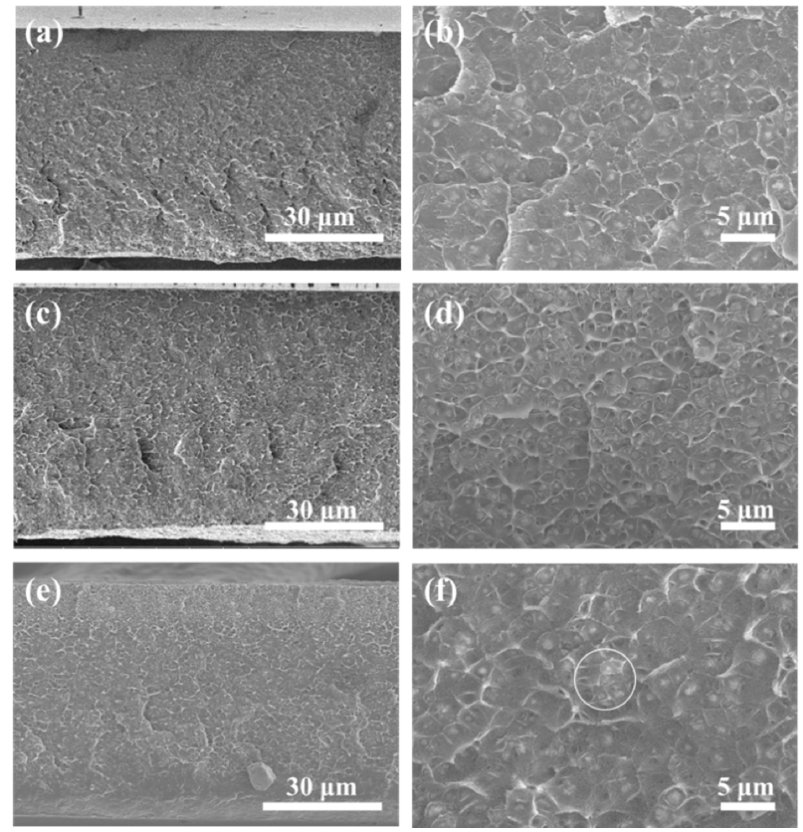
Figure 4. ( a , b ) Cross-section SEM images of UiO-66-NH 2 @IL/PIM-1 MMM with 10 wt.%, ( c , d ) 20 wt.%, and ( e , f ) 30 wt.% filler loadings. ( c , d ) 20 wt.%, and ( e , f ) 30 wt.% filler